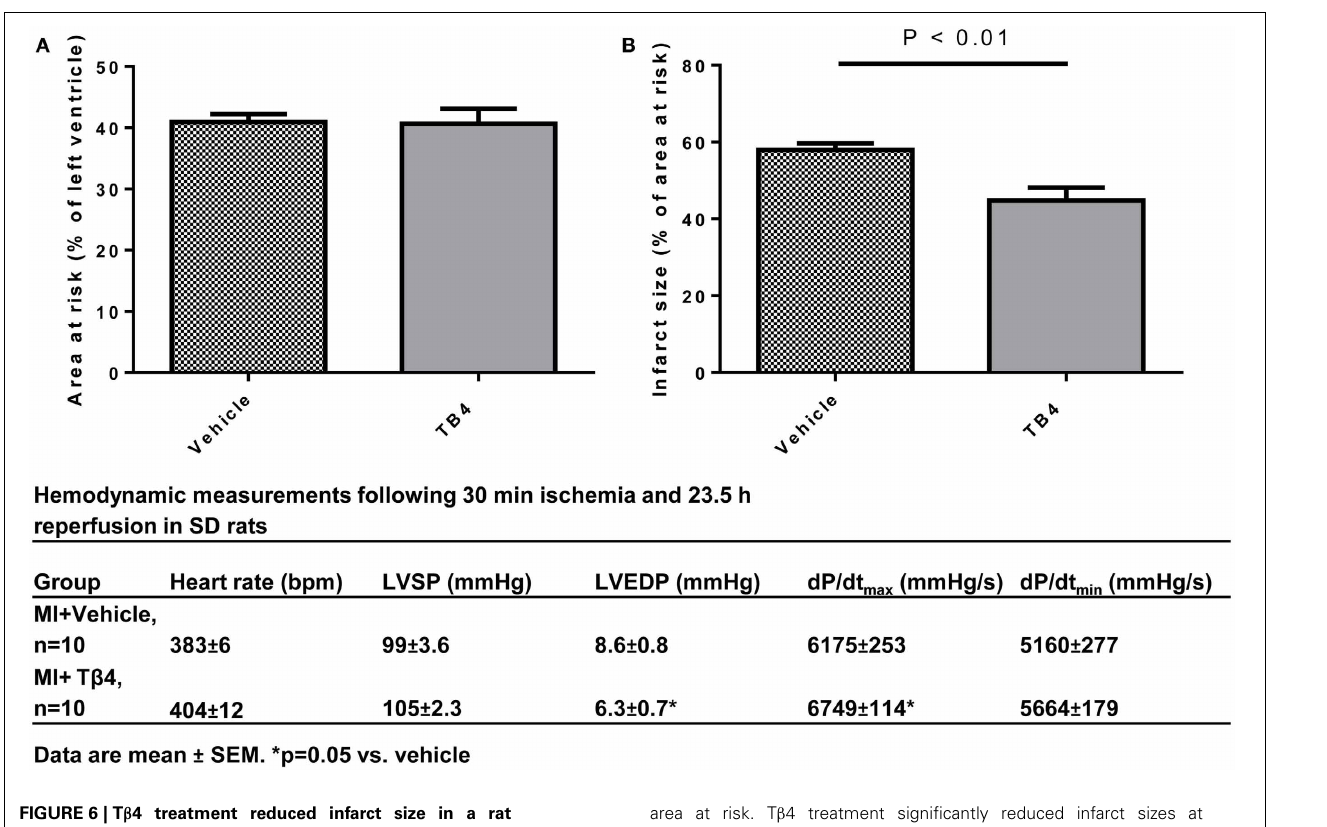
area at risk. T β 4 treatment significantly reduced infarct sizes at 23.5h postischemic injury. (B) Table describing hemodynamic measurements at end-of-study. End-diastolic pressures were reduced and dP/dtmax was increased in the T β 4-treated group in comparison to the vehicle-treated